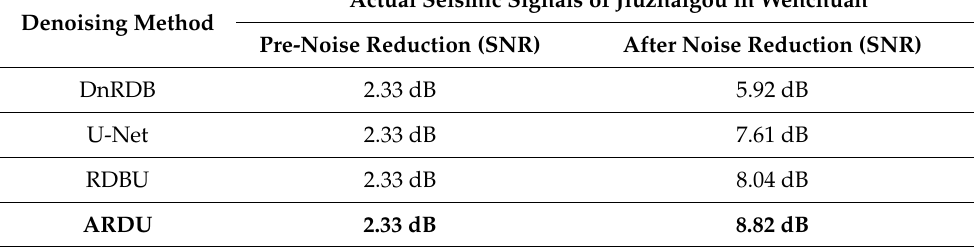
Table 4. Denoising results of actual seismic signals using the ARDU model. Denoising